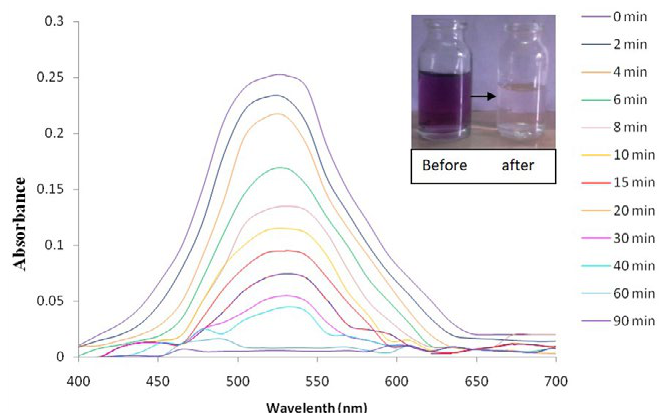
Fig. 2: Plot of concentration (ppm) Vs Time (min)